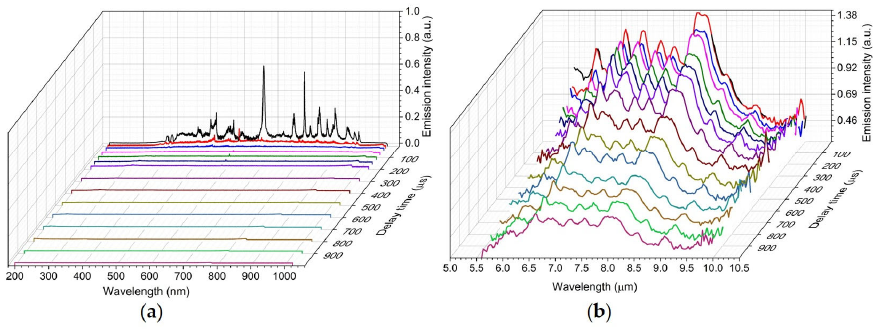
Figure 4. Simultaneous UV/Vis/NIR ( a ) + LWIR ( b ) LIBS spectrum of acetaminophen tablet measured at a delay time of 1 µs, 20 µs, 40 µs, 80 µs, 120 µs, 160 µs, 200 µs, 300 µs, 400 µs, 500 µs, 600 µs, 700 µs, 800 µs, 900 µs, and 1000 µs.